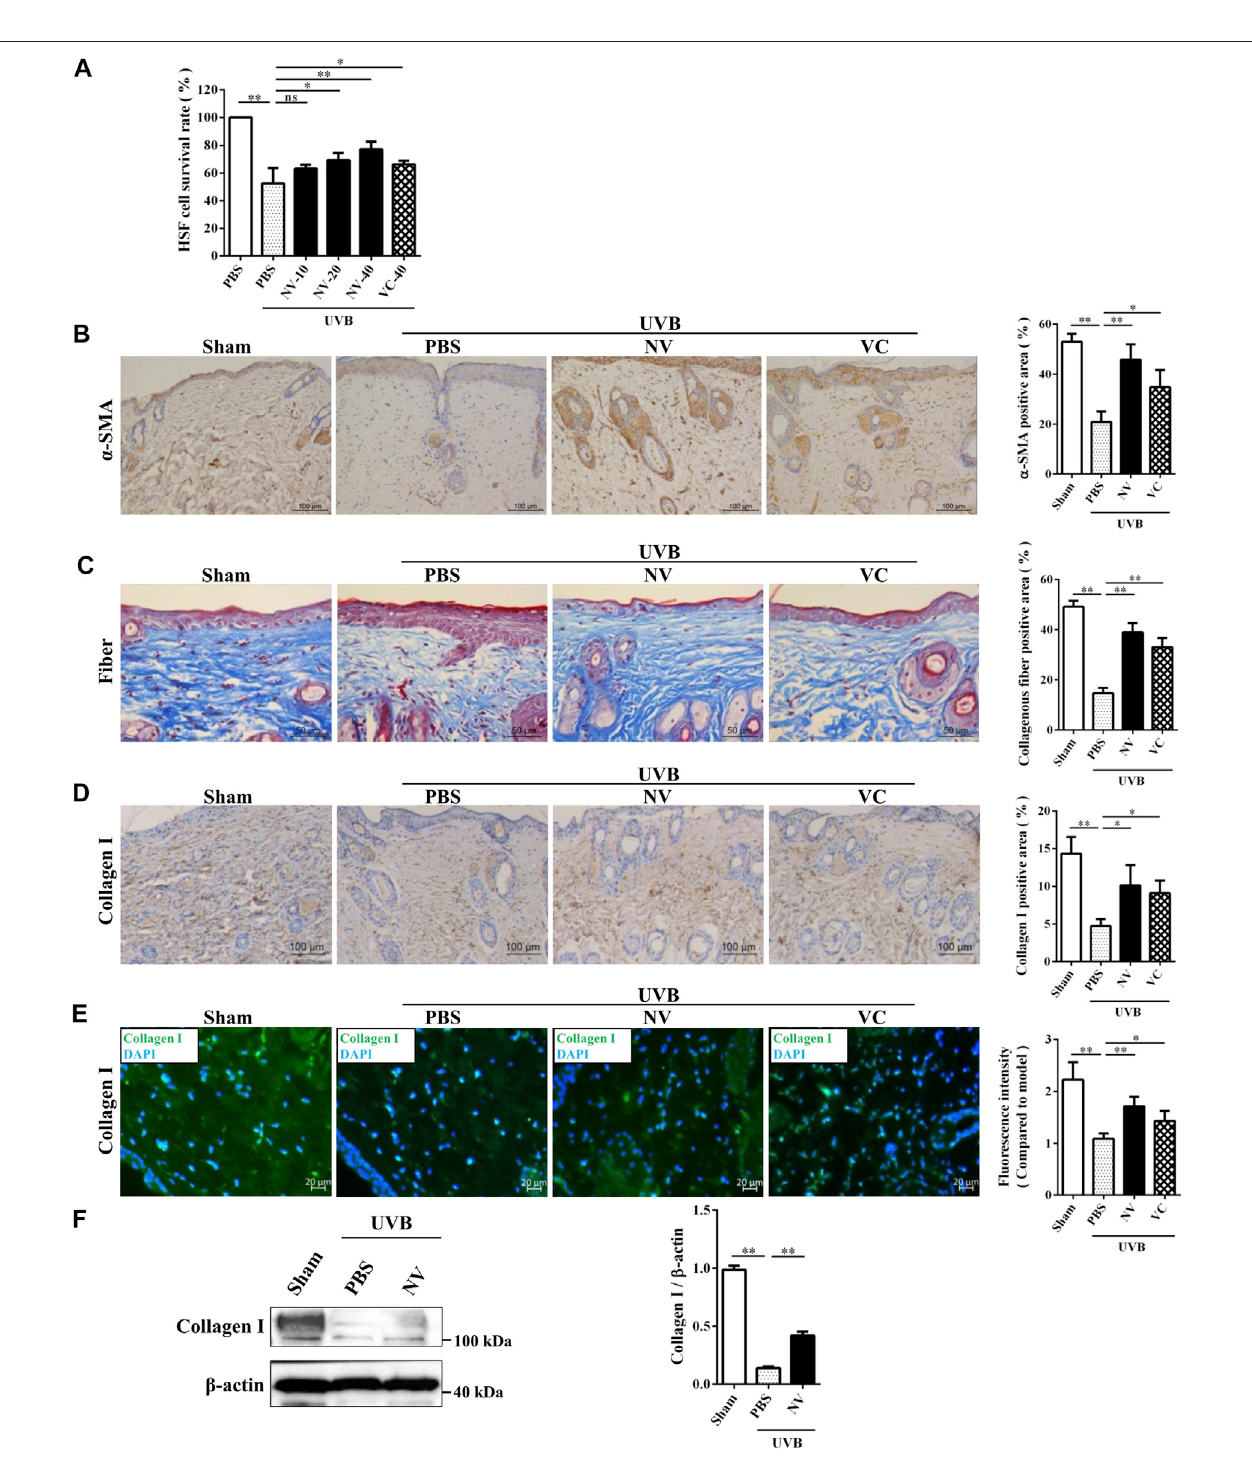
FIGURE 9 | Antioxidin-NV rescued a-SMA accumulation and increased the expression of type I collagen in hairless mice. (A) Cultured HSF cells were treated with antioxidin-NV with indicated concentration, and the survival rate of cells were estimated. (B) The skin tissues were taken and paraf fi n blocks were cut into 4 μ m thick sections for α -SMA immunohistochemical. Myo fi broblast are stained brown (Indicated by red arrow). Scale bar (cid:1) 100 μ m. Quanti fi cation of α -SMA-positive area. (C) Masson ’ s trichrome staining estimated for relative collagen density and Quanti fi cation of collagen-positive area. Collagenous fi ber is stained blue. Scale bar (cid:1) 50 μ m. (D) IHC staining of skin tissues was used to determine the expression levels of Collagen I. Collagen I are stained brown (Indicated by red arrow). Scale bar (cid:1) 100 μ m. (E) Immuno fl uorescencestainingofskintissueswasusedtodeterminetheexpressionlevelsofCollagenIandimmuno fl uorescenceintensityanalysis.Collagen I is stained green. Scale bar (cid:1) 20 μ m. (F) Western blot analysis of protein expression in skin tissues and relative expression analysis. Data are presented as mean ± SD ( n (cid:1) 3). NV-10, 20, 40 indicated the concentrations of 10, 20, 40 μ g/ml respectively. ns, no signi fi cance, * p < 0.05, ** p < 0.01.